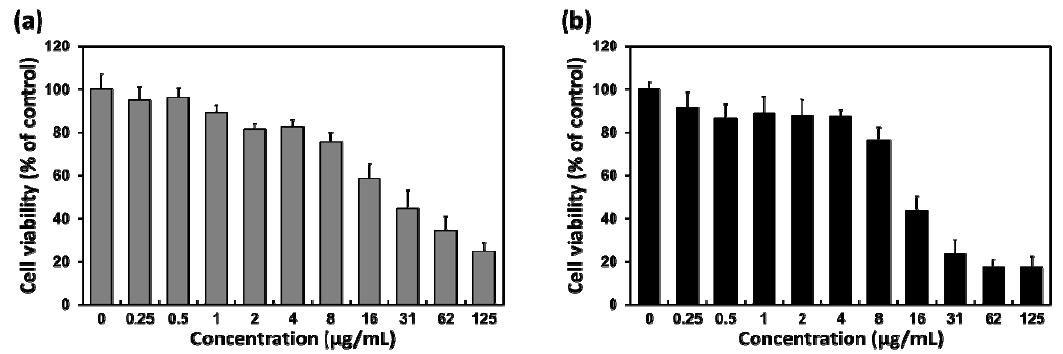
Figure 5. Cell viability profiles of L-929 fibroblasts after ( a ) 48 and ( b ) 72 h of incubation with various concentrations of layered BP.